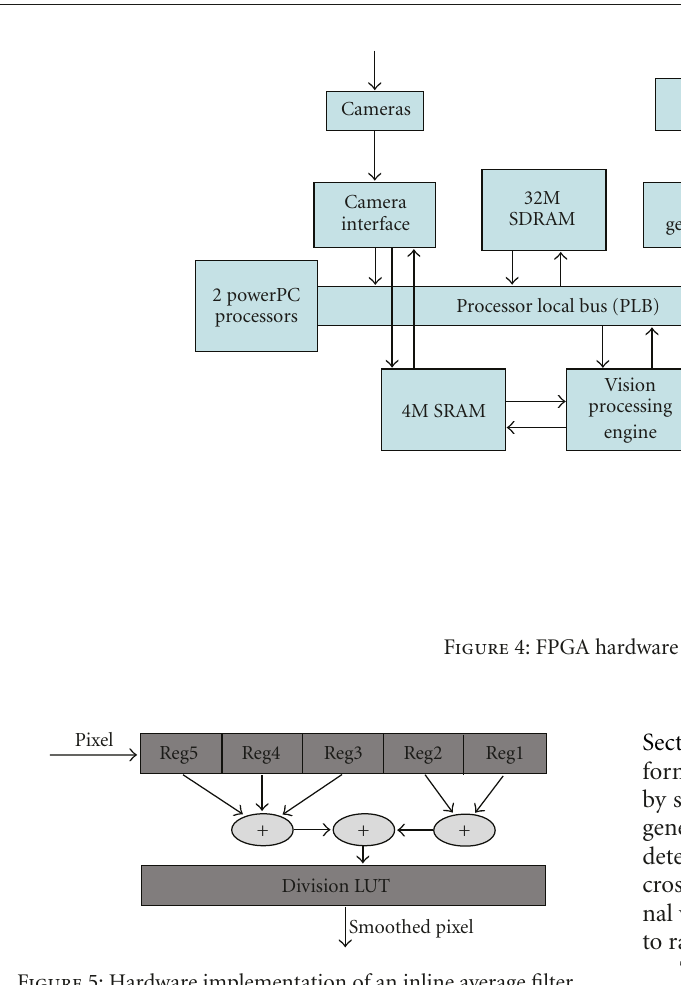
Figure 5: Hardware implementation of an inline average filter.